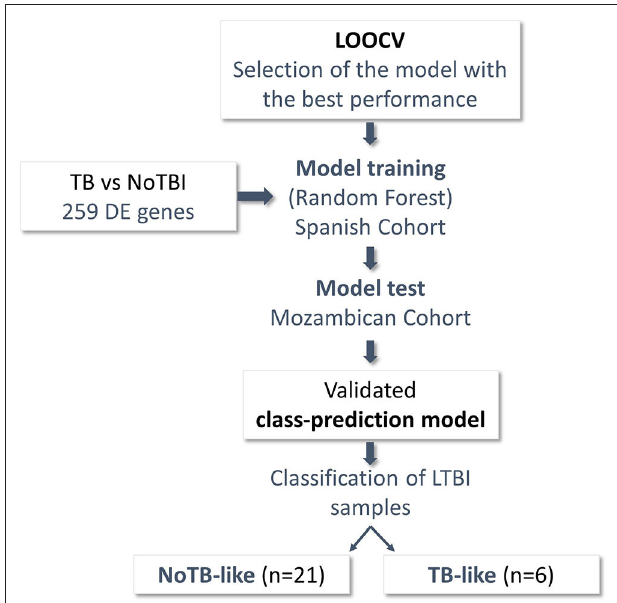
FIGURE 4 | Schematic representation of the steps followed to classify the LTBI samples. Differentially Expressed (DE) genes between patients with confirmed infection (28 Active TB) and uninfected individuals (41 NoTBI) were used to create a class-prediction model. A leave-one-out Cross-validation (LOOCV) was used to select the classification algorithm. Random Forest algorithm, the one with the best performance in the LOOCV, was used to build a class-prediction model using the samples from the Spanish cohort (training set) as an input. The model was validated on an independent Mozambican cohort (test set). The validated model was then applied to the LTBI samples from the Spanish cohort to study their similarity to either the active TB patients or the uninfected contacts. Two subgroups were identified within the LTBI contacts, named TB-like and NoTB-like